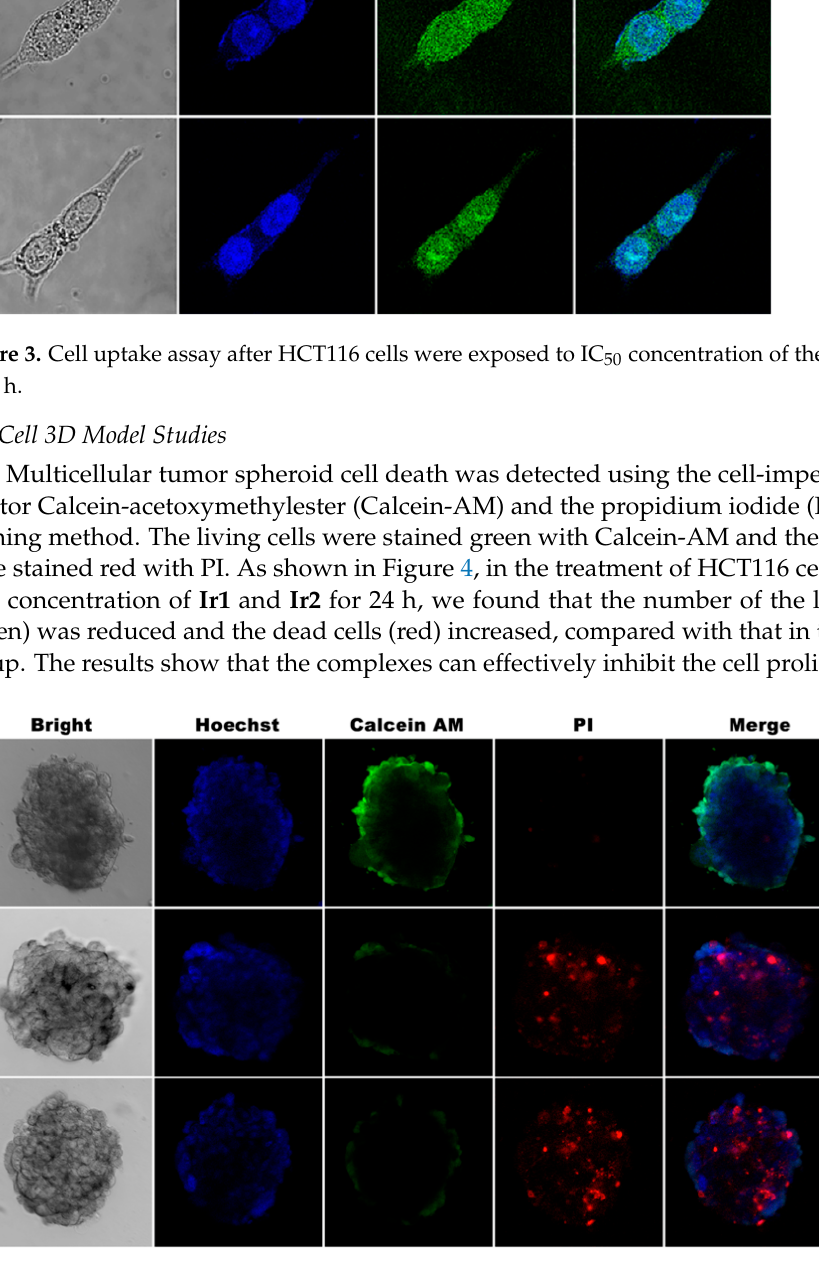
Figure 4. Multicellular tumor spheroids (3D) assay of HCT116 cells exposed to IC 50 concentration of Ir1 and Ir2 for 24 h.